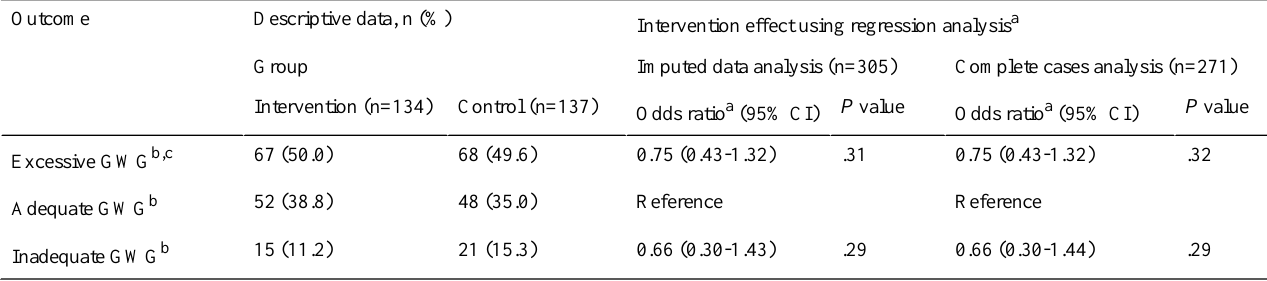
Table 4. Intervention effect on gestational weight gain according to National Academy of Medicine’s recommendations.